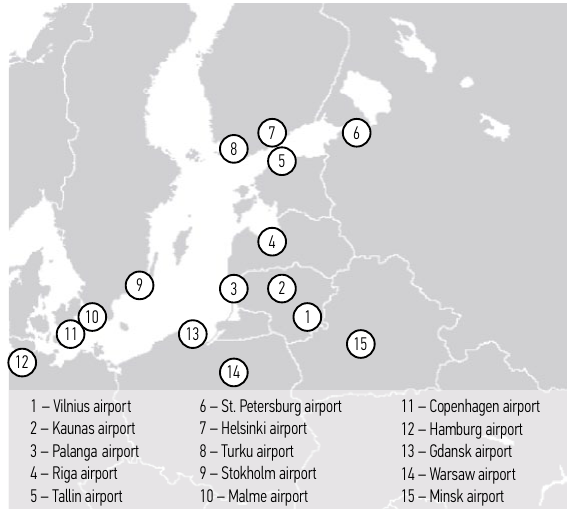
Fig. 1. The set of